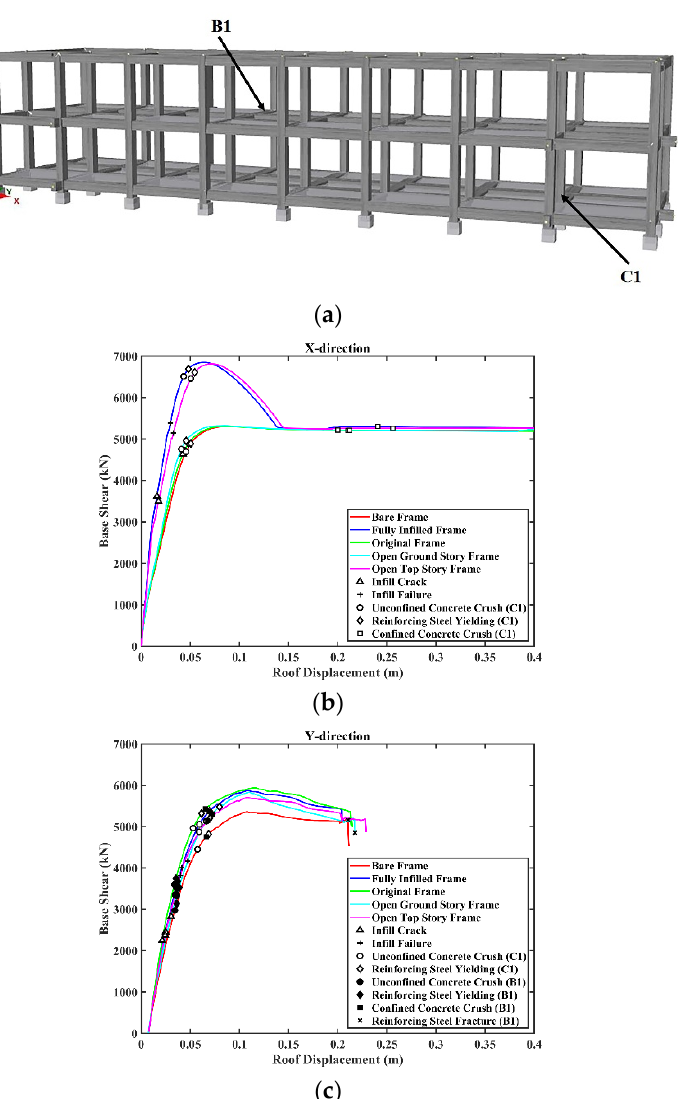
Figure 12. Observed locations and pushover curve of EDU: ( a ) Column C1 and beam B1; ( b ) x- direction; ( c ) y-direction.